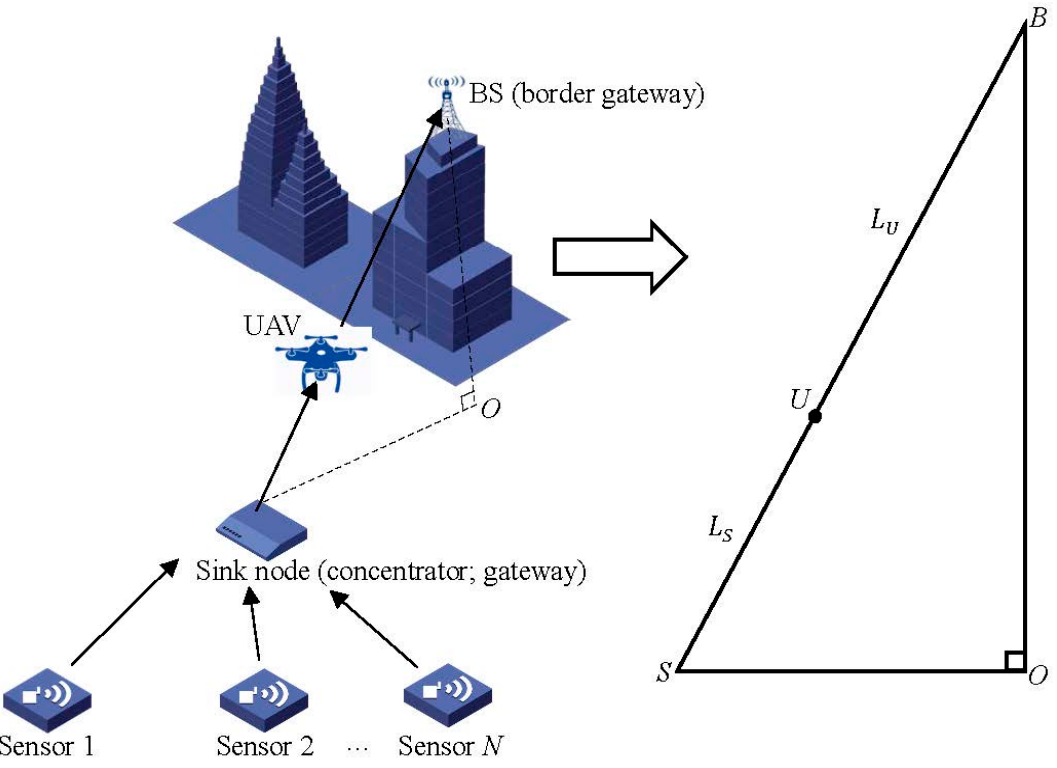
Figure 1. System model of the unmanned aerial vehicle (UAV) based relay in wireless sensor networks (WSN).